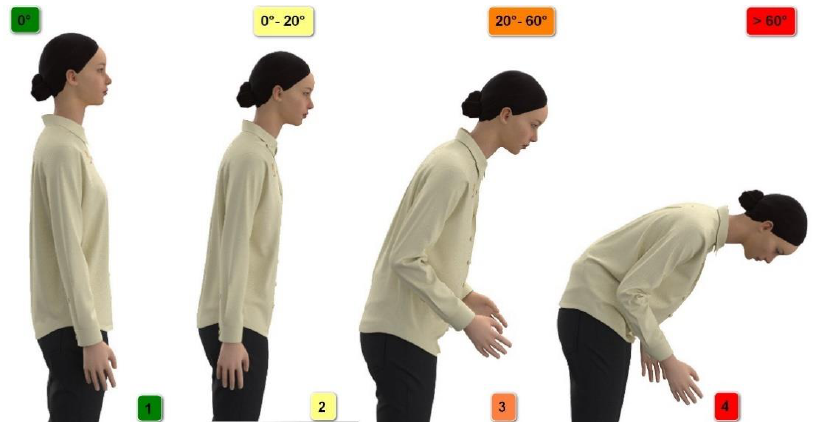
Figure 2. Trunk positions with the score points for the angle of flexion.